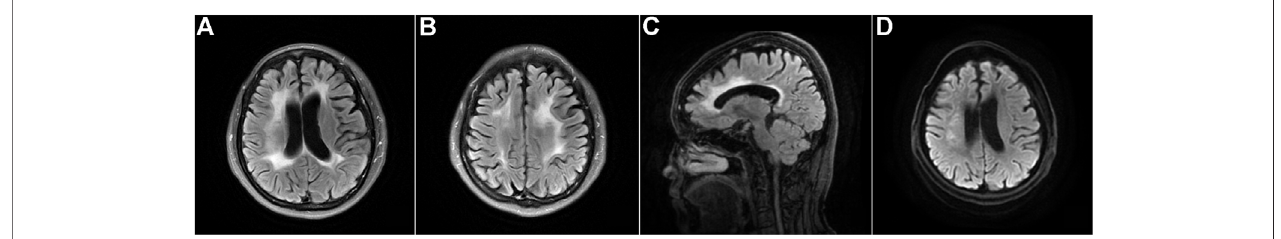
FIGURE 4 | Brain neuroimaging of the proband ’ s sister (patient Ⅲ -10) with CSF1R-microglial encephalopathy. Bilateral diffuse hyperintense lesions affecting the periventricularwhitematter,corpuscallosum,anddeepareasofthefrontoparietallobesonthebrainaxialFLAIR (A,B) andDWI (D) .SagittalbrainFLAIRshowsabnormal hyperintensities and thinning of the corpus callosum, and extensive cortical atrophy (C) .